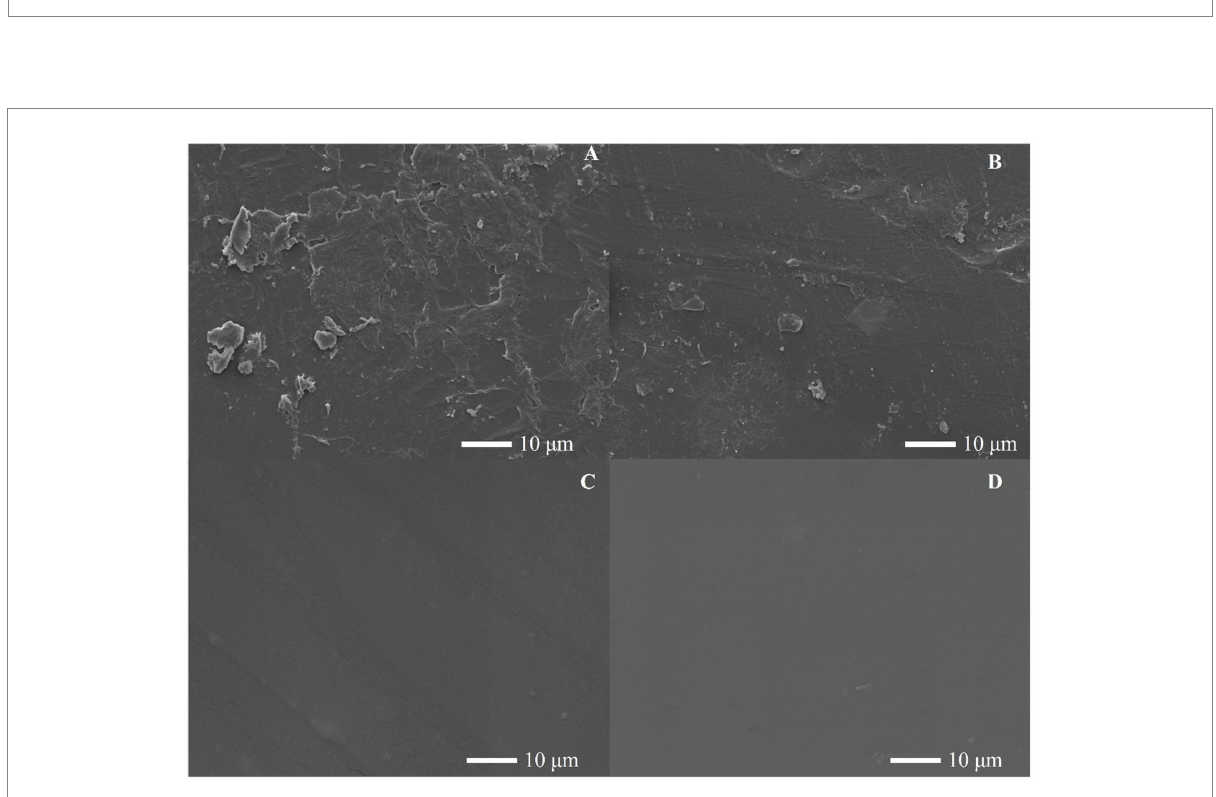
FIGURE 6 SEM images of the PET films surface treated by E. coli contained (A) HCSD; (B) CSD-PETase; (C) HCSD-HFBII expression system for 96 h, (D) PET film without any